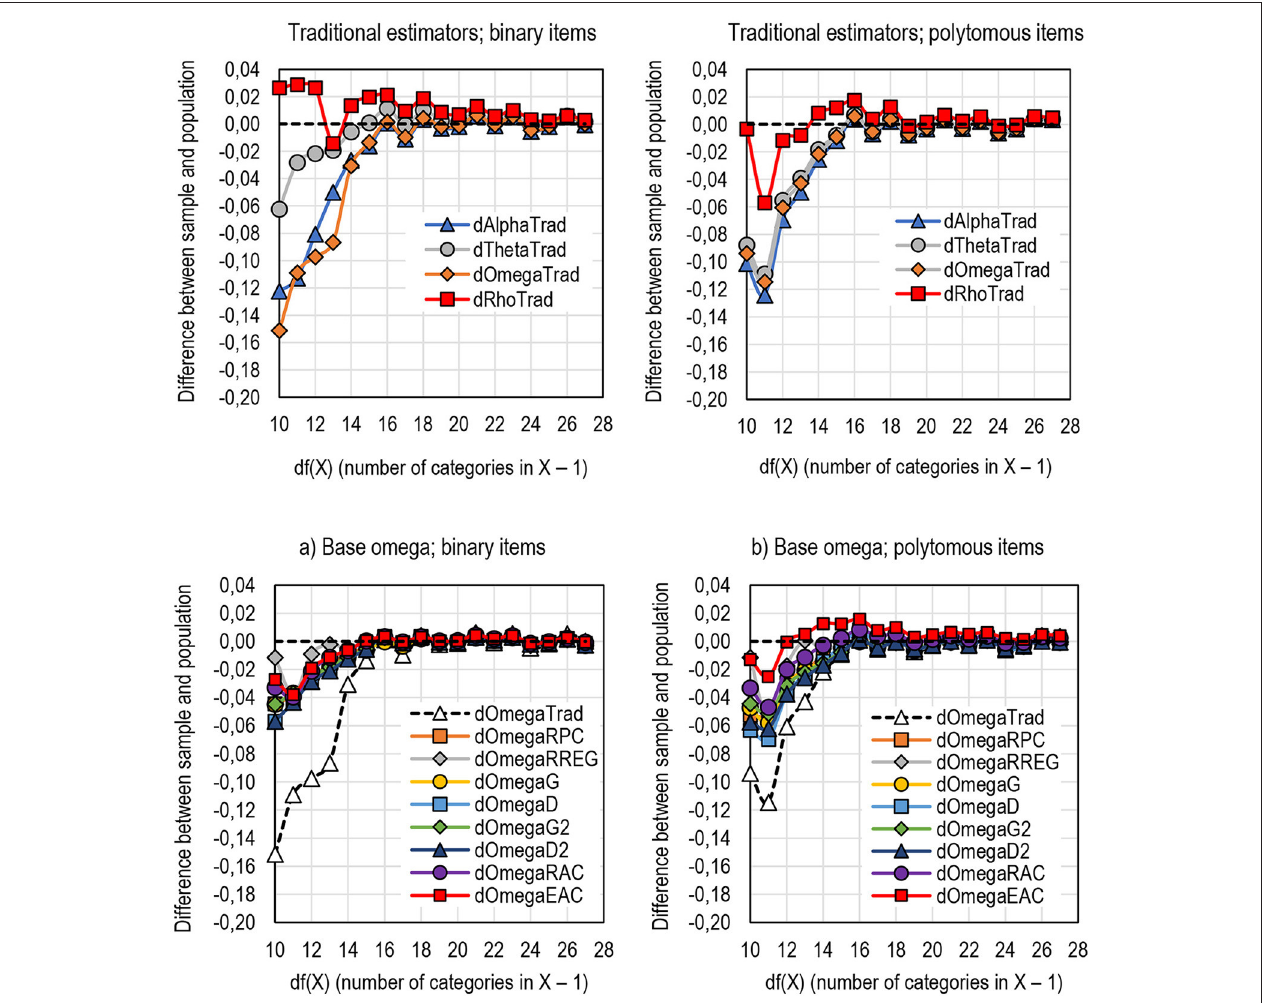
FIGURE 10 | The behavior of traditional estimators of reliability by the width of the score [df(X)]. The behavior of DCERs by the width of the score [df(X)]. (a) Base omega; binary items. (b) Base omega; polytomous